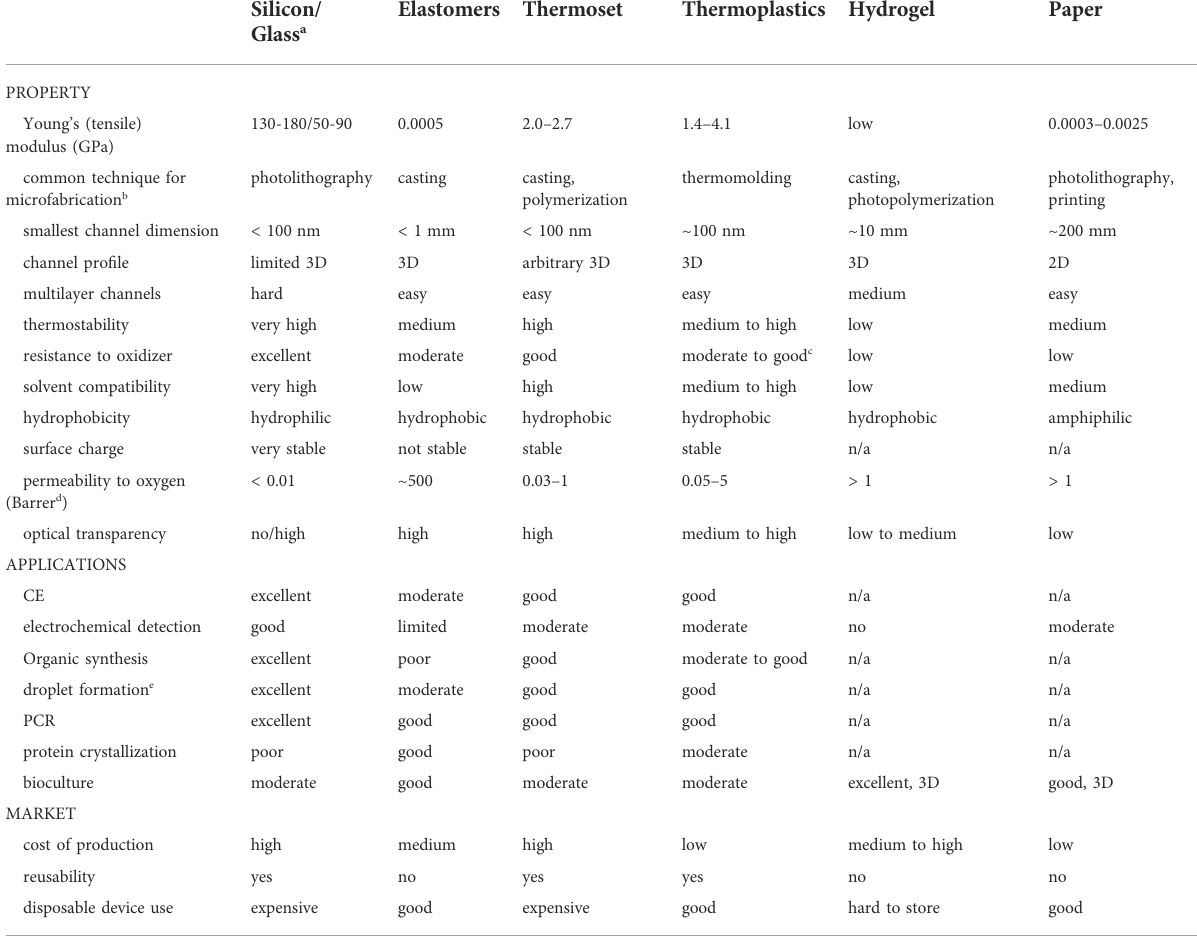
TABLE 3 Overview of properties and applications of materials commonly used in micro fl uidics (adapted from Ren et al.,